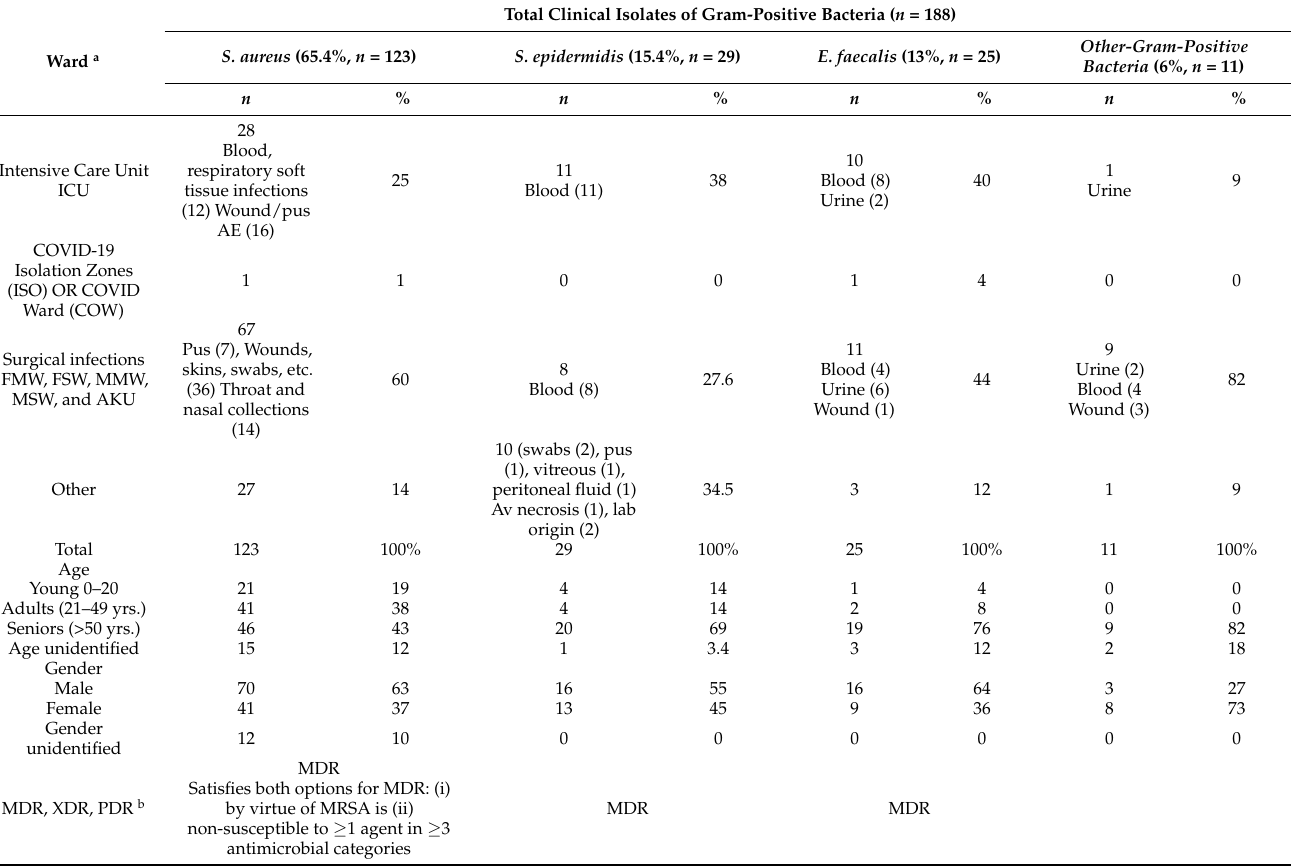
Table 1. Specimen types, sources, patient demographics, and antimicrobial resistance definitions of major Gram-positive bacteria recovered from clinical isolates in Ha’il hospitals, Saudi Arabia. Total Clinical Isolates of Gram-Positive Bacteria ( n =